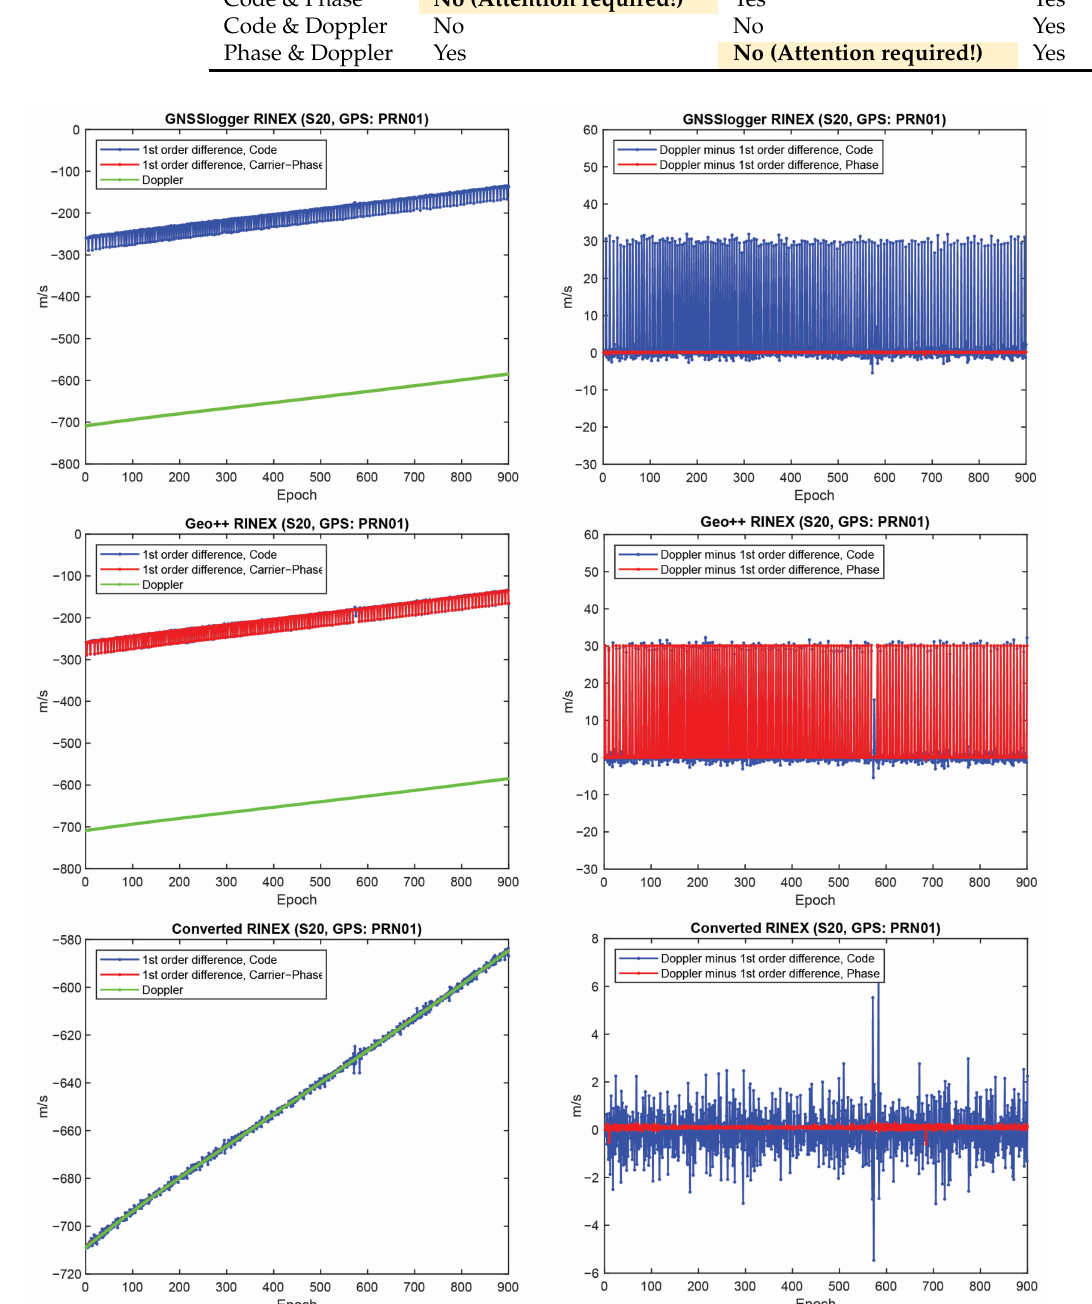
Figure 6. First-order differentiation of GPS pseudorange and carrier-phase observations as well as Doppler observations on L1 frequency for PRN 01 (Samsung